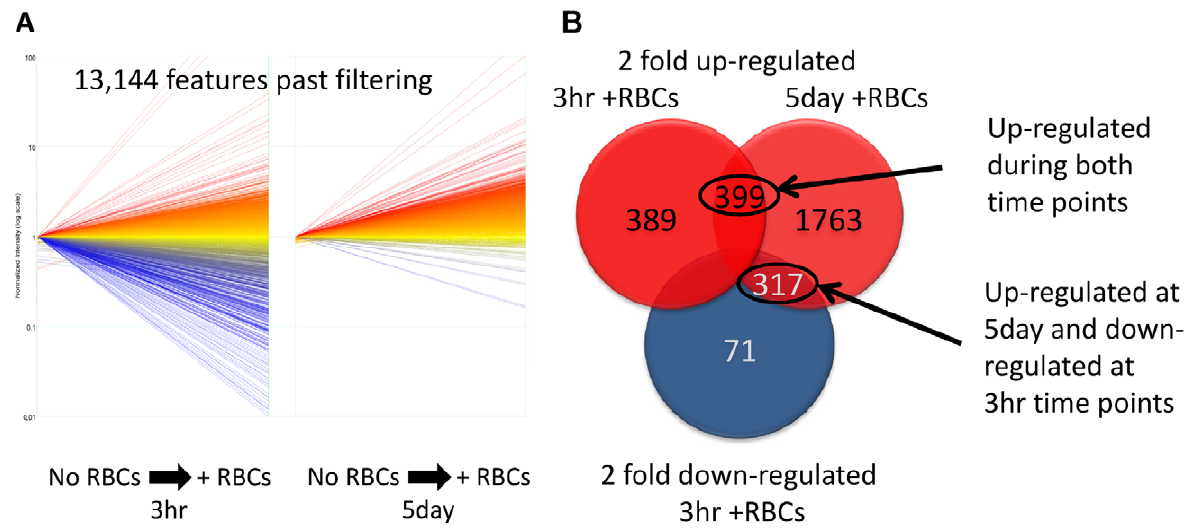
Figure 3. Number of genes differentially expressed in 3 h and 5 day cultured S. mansoni schistosomula in the presence of erythrocytes. (A) Scatter plot of the overall change in expression of 3 h and 5 day old schistosomula, cultured in the presence of erythrocytes and normalised to parasites cultured without erythrocytes. Relative up-regulation is shown in red, and relative down-regulation in blue. No differential gene expression is presented in yellow (B) Number of genes either up- or down-regulated . 2-fold in 3 h or 5 day schistosomula cultured in the presence of erythrocytes relative to parasites cultured without erythrocytes; numbers in the overlapping region of the Venn diagram indicate genes that were differentially expressed in more than one group. Relative up-regulation is shown in red, and relative down-regulation in blue. Number of up-regulated genes in both time points (3 h and 5 day) and number of genes up-regulated at 5 day but down-regulated at 3 h time points are circled and annotated.